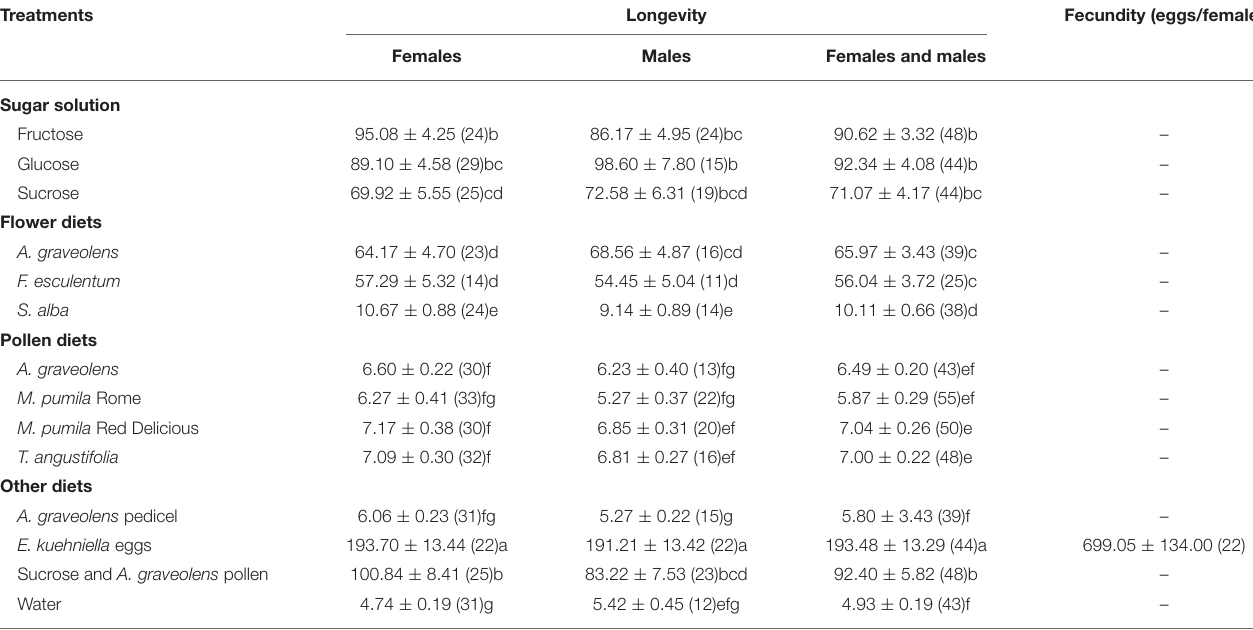
TABLE 3 | Longevity (days) and fecundity (mean ± SE) of A. bipunctata adults fed on different diets.